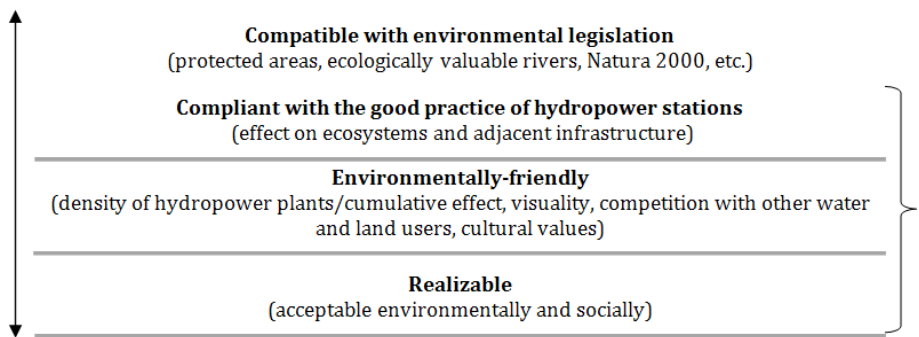
Fig. 2. Compatible hydropower and environmental procedures (Punys et al.,